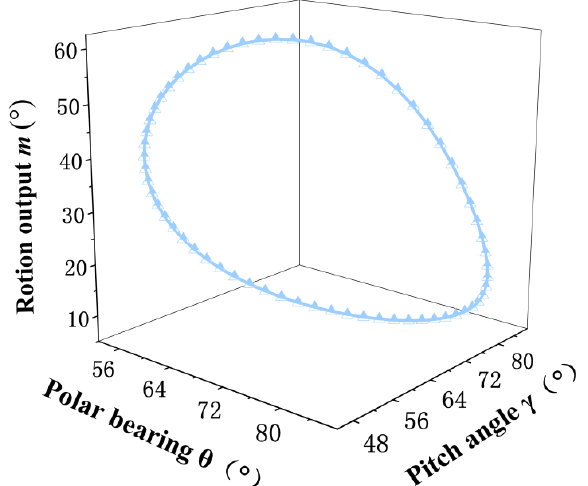
Figure 10. Design